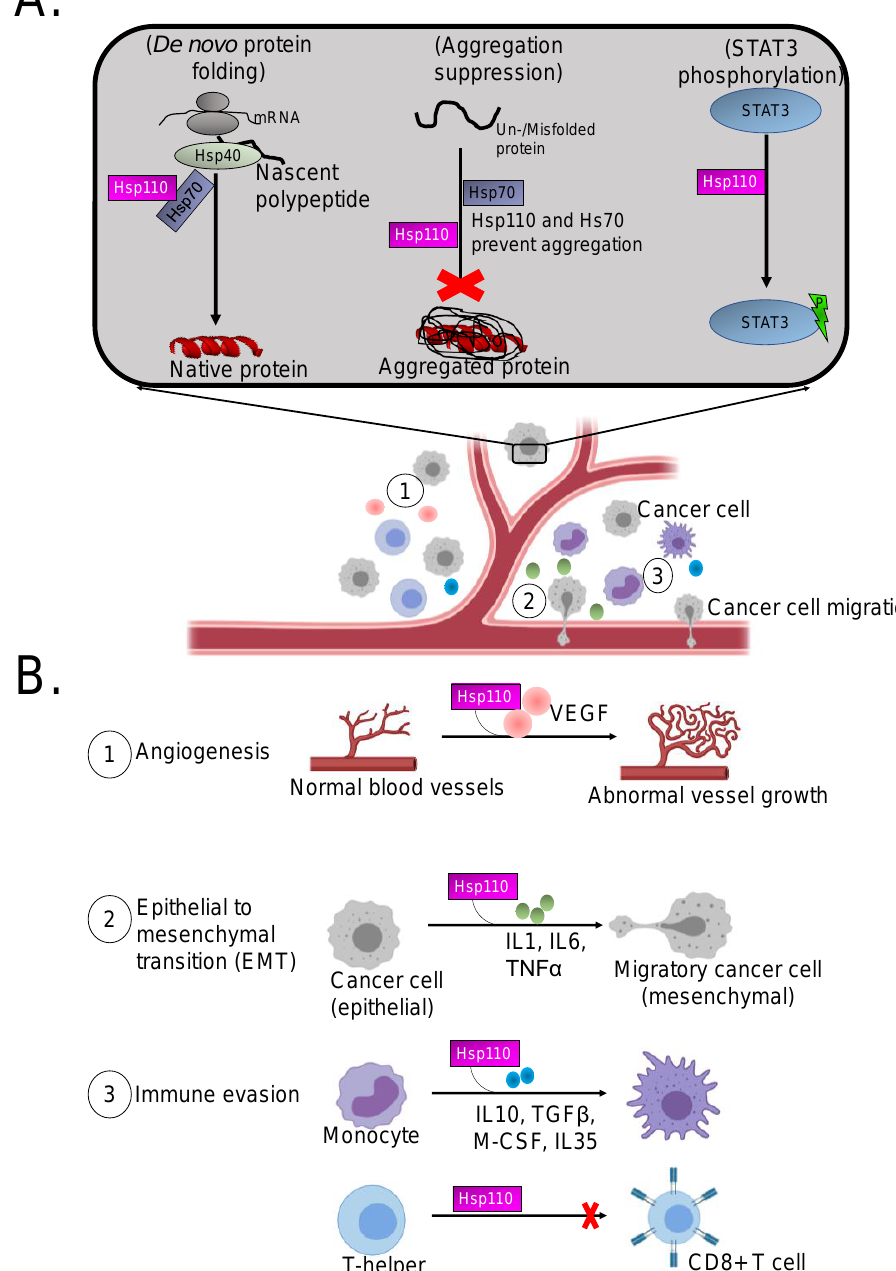
Figure 3. Roles of Hsp110 in cancer cells: ( A ) Hsp110 co-operates with Hsp70 complexed to its co-chaperone Hsp40 to facilitate folding of nascent polypeptides in tumor cells. Hsp110 also independently suppresses aggregation of oncogenic proteins and regulates functional competence of molecules such as STAT3 whose phosphorylation it facilitates, thereby promoting tumor cell proliferation. ( B ) Hsp110 modulates metastasis in tumour cells via interaction with VEGF leading to abnormal angiogenesis (1). Hsp110 is also involved in EMT via association with proinflammatory cytokines (2) and in immune evasion pathways (3) which ultimately result in metastasis.